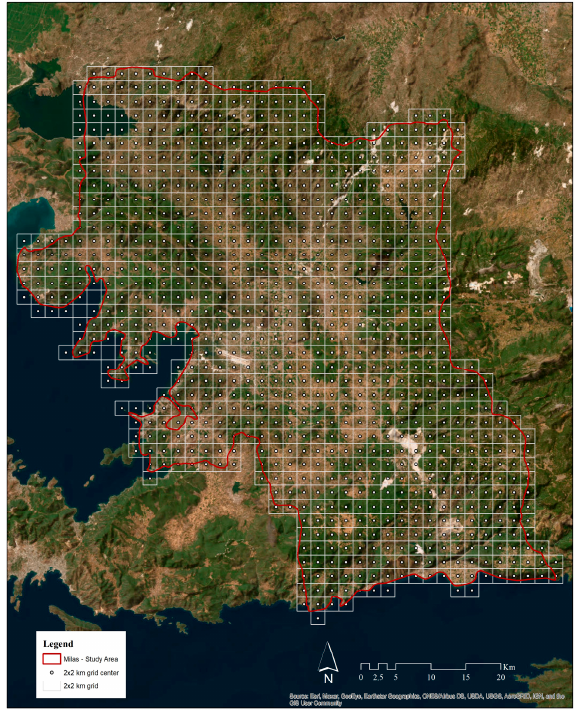
Figure 6. Grid centers with a background.